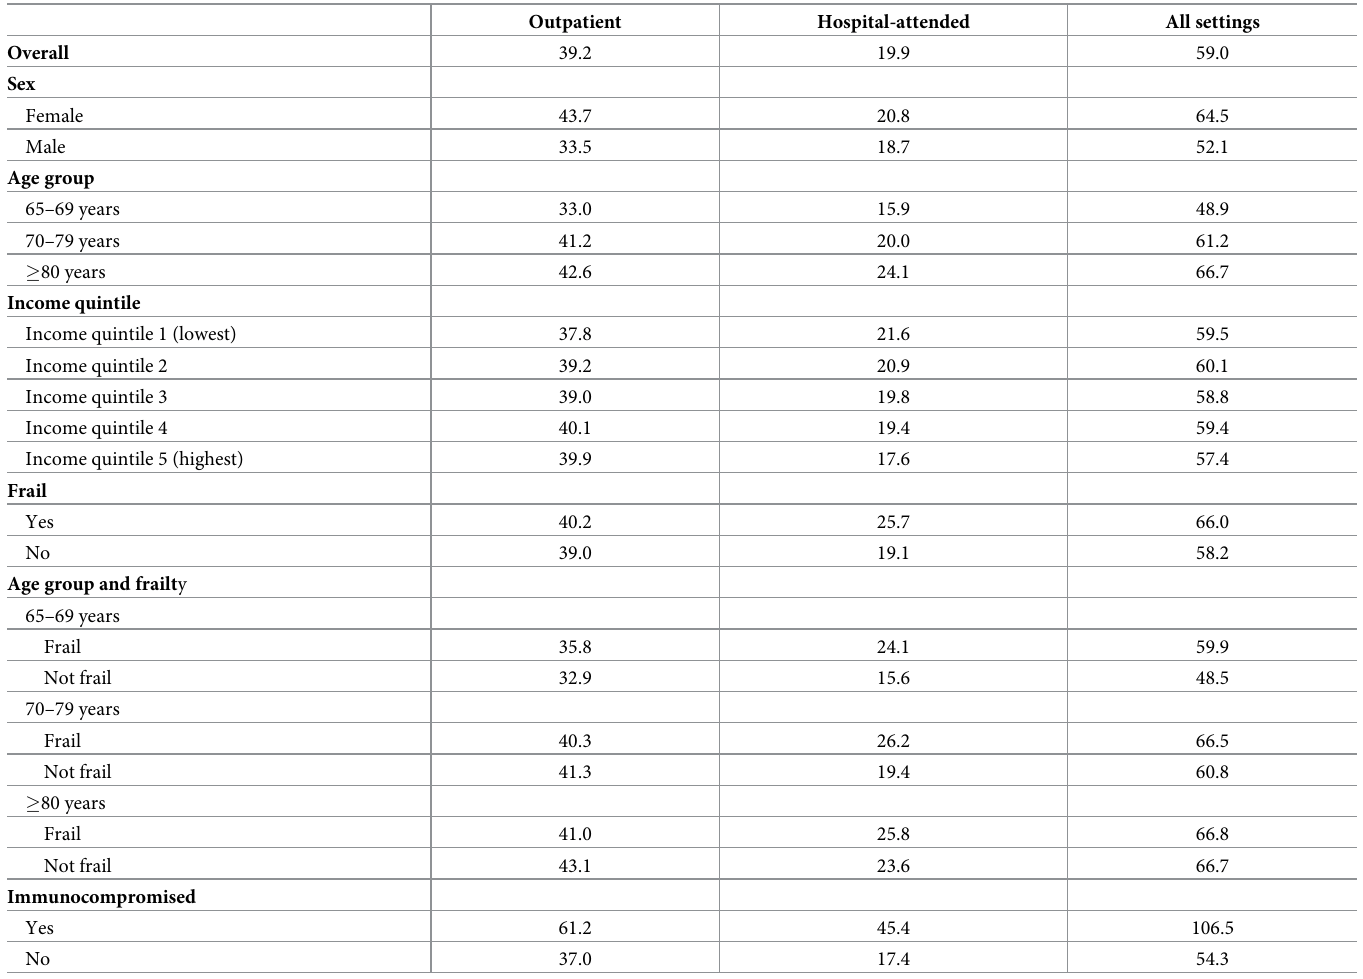
Table 2. Annual incidence of herpes zoster per 10,000 by setting and overall,